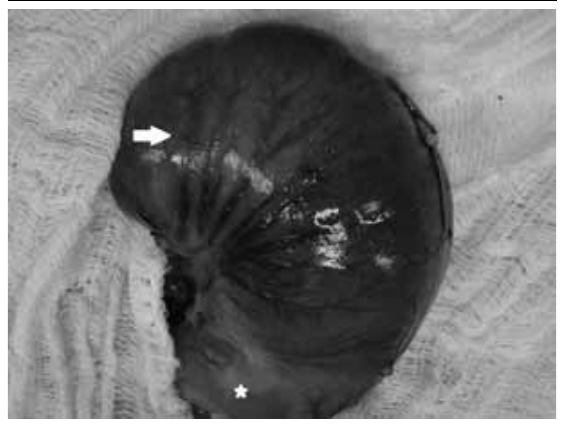
figurE 1 – Macroscopic aspect of the closed stomach of the rabbit after 6 hours of gastric ischemia. The outer surface of the stomach exhibits signs of hemorrhagic necrosis of the body region (arrow), whereas the antropyloric region (*) is